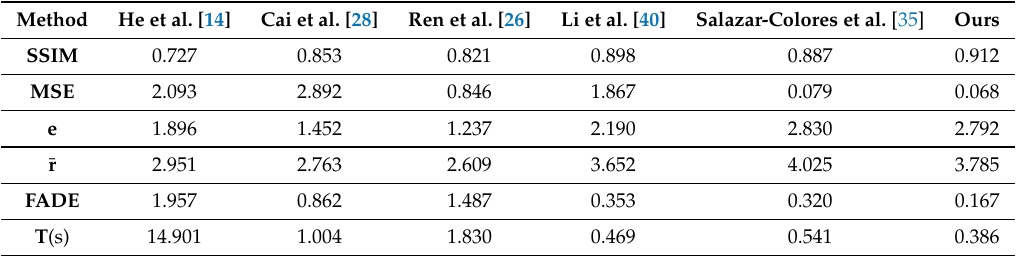
Table 3. The average values of MSE , SSIM , e , ¯ r , FADE , and T on synthetic hazy images of the comparative